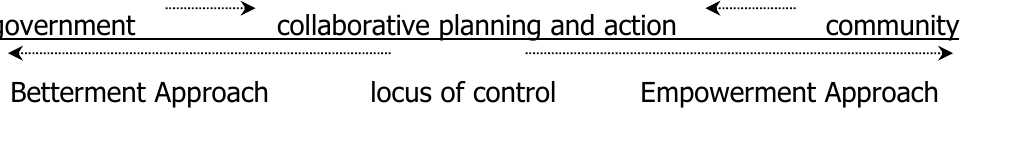
Establishing locus of control for collaborations